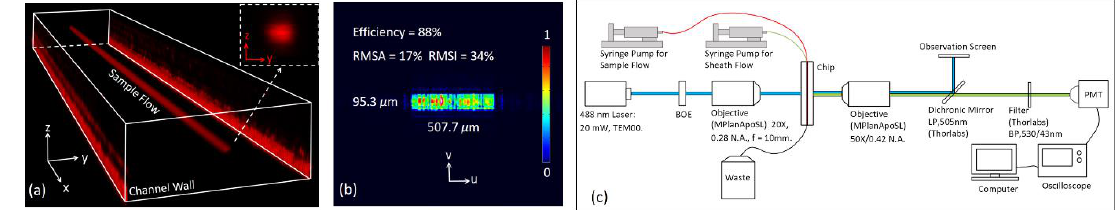
Figure 4. ( a ) The focused sample flow was a narrow stream along the centerline in the straight channel; ( b ) The spot intensity distribution captured by the profiler; ( c ) The microflow cytometer schematic.